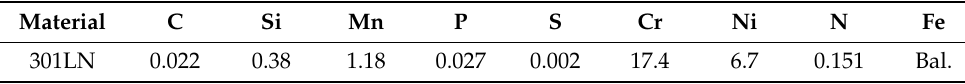
Table 1. Chemical composition of AISI 301LN steel in